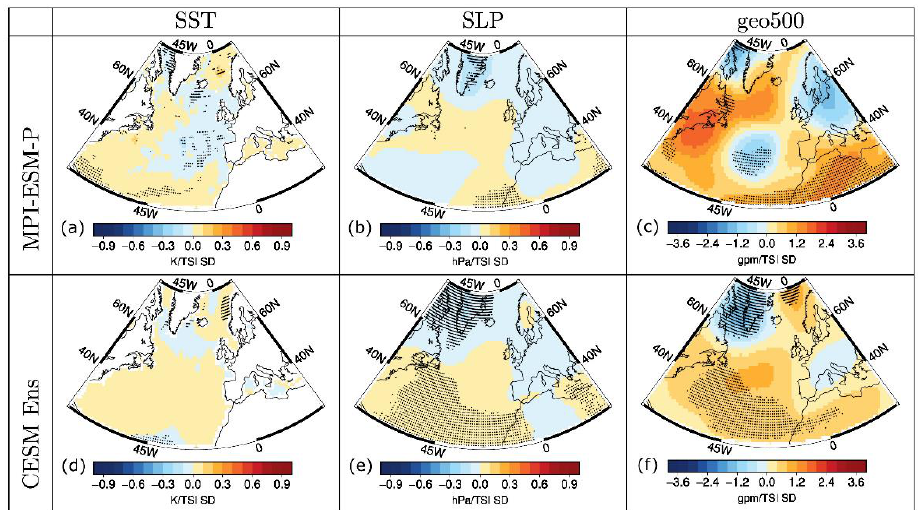
Figure 2. Correlation patterns between TSI and the SST ( a , d ), the SLP ( b , e ) and the geo500 ( c , f ) for the MPI-ESM-P ( a – c ) and CESM ensemble mean ( d – f ). The hatched areas indicate statistical significance at the 5% level. The range of r-values for SST, SLP and geo500 is approximately ±0.3, ±0.2, and ±0.4, respectively.